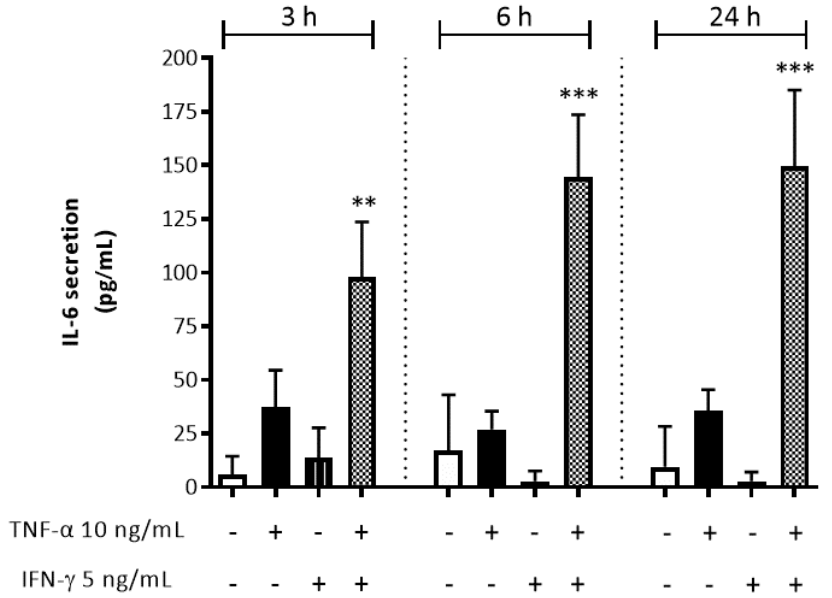
Figure A3. Preliminary time course experiment aimed at assessing IL-6 release from HaCaT cells stimulated with TNF-α (10 ng/mL), IFN-γ (5 ng/mL), or a combination of both; ** p < 0.01, *** p < 0.001 vs. stimulus.